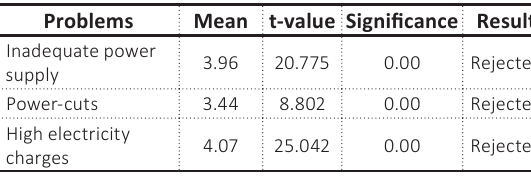
Table 7. Power supply challenges